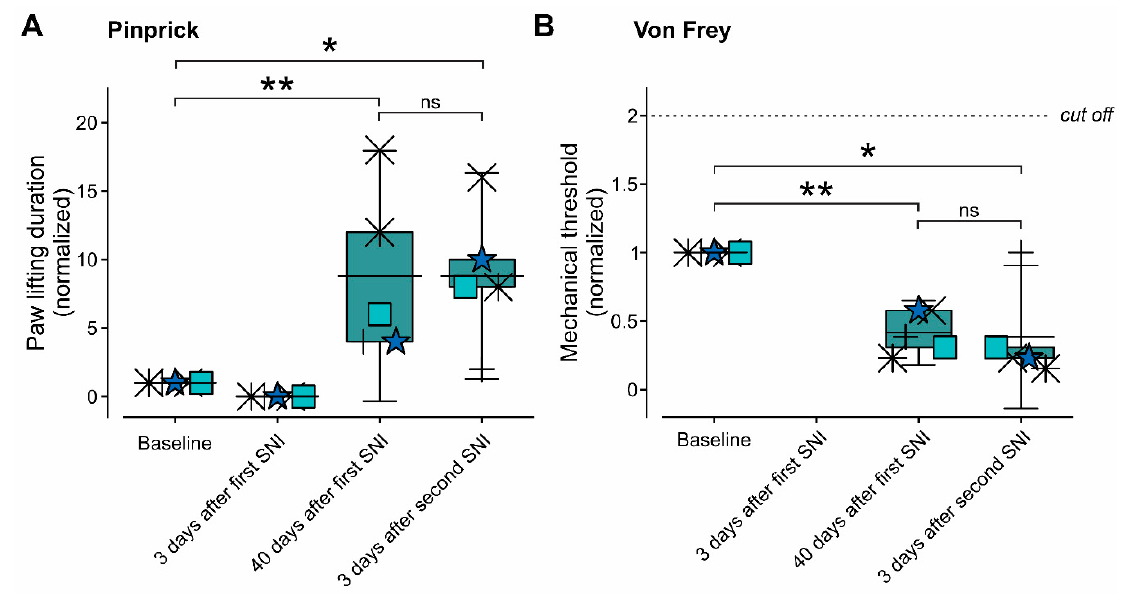
Figure 5. Reinnervation does not originate from lacerated tibial and peroneal nerves but is resulted from sprouting from the axons innervating neighboring areas. ( A , B ) Box plots and paired individual values of normalized paw lifting latencies, measured using calibrated pinprick ( A ) and mechanical threshold, measured using VF ( B ) before SNI surgery (baseline); three and 40 days after the first SNI and three days after repeated SNI. Note no values for the mechanical threshold 3 days after SNI ( B ) as all animals did not respond to the cut off value of the VF. Note no significant difference between the values of the mechanical threshold and paw lifting duration measured 40 days after SNI and three days after the second SNI. The baseline value represents the mean values of three tests performed at three consecutive days before SNI or sham surgery. All of the values were normalized to the baseline value. ** p < 0.01; * p < 0.05; ns—not significant, RM one-way ANOVA. Box plots presented in the figures depict mean; 25th; 75th percentile and SD.